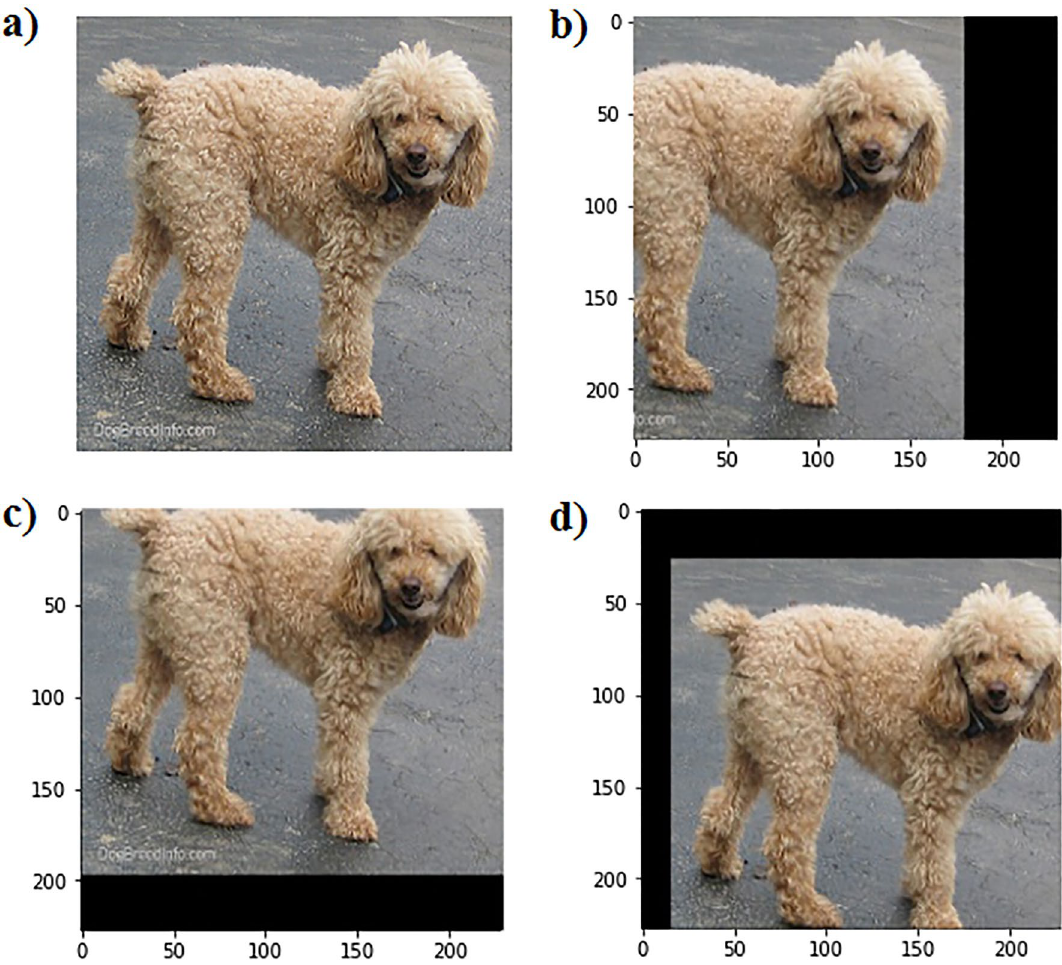
Figure 9. ( a ) A sample image from Kaggle Cats and Dogs dataset, and its translated version by ( b ) − 50 pixels shift toward the x-direction, ( c ) − 30 pixels shift toward the y-direction, and ( d ) (15, 26) pixels shift toward the (x,y) direction.